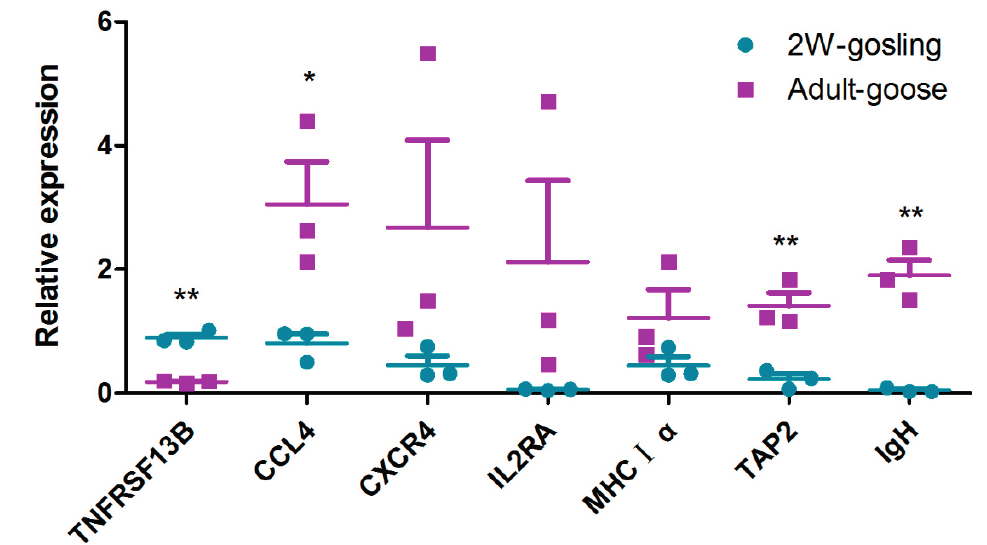
Figure 9. Validation of the gene expression profile by qRT-PCR. Each dot represents an individual goose in one of the two groups (one group is two-week-old goslings; the other group is adult geese). The mRNA level of each spleen sample was quantified by qRT-PCR in triplicate for each gene. GAPDH was amplified as an internal control. The chart was constructed in GraphPad Prism 5. The relative expression levels were compared using multiple t -tests. Data are represented as the mean ± SEM ( n = 3). For gene symbols representing different genes, refer to Table 4. * indicates significant differences ( p ≤ 0.05), ** indicates extremely significant differences ( p ≤